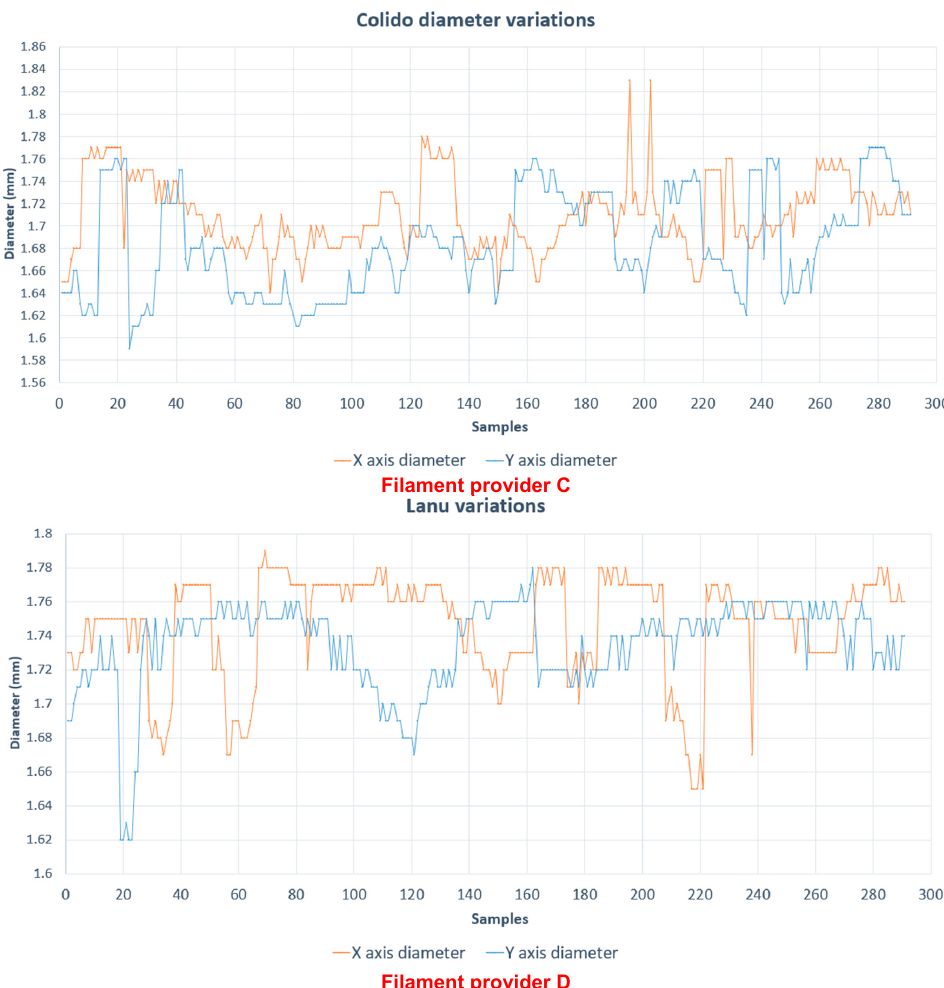
Figure 4. Diameter variation for four different filament providers (A, B, C, D).